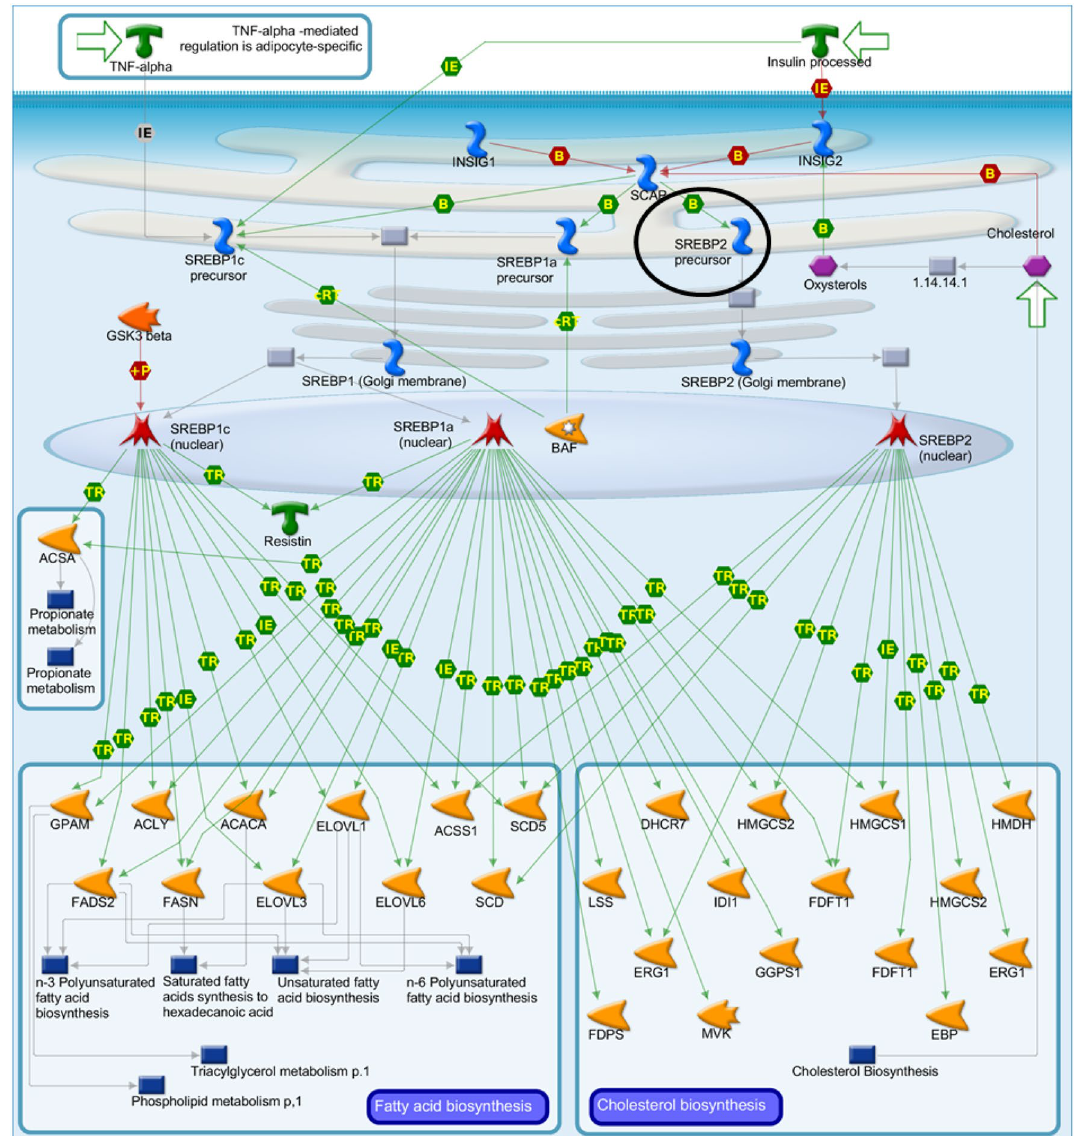
Figure 2. SCAP/SREBP transcriptional control of cholesterol and fatty acid biosynthesis pathway map. Image created by MetaCore (Clarivate Analytics) [https:// portal. genego. com/]. Activation is indicated by green arrows, inhibition is indicated by red arrows, and unspecific relationship is indicated by gray arrows. The SREBP2 precursor is highlighted with a black circle. Nodes represent GeneGo Network objects (genes or gene complexes). For more information, see https:// portal. genego. com/ legen ds/ MetaC oreQu ickRe feren ceGui de.